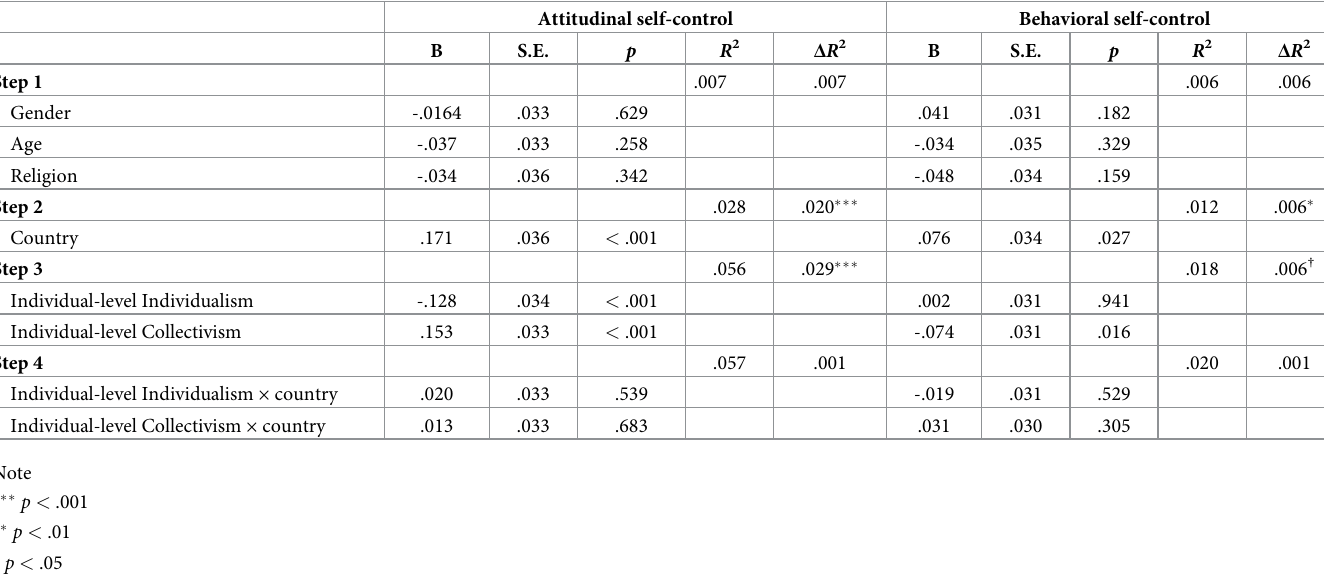
Table 3. Regression of attitudinal and behavioral self-control on individualism and